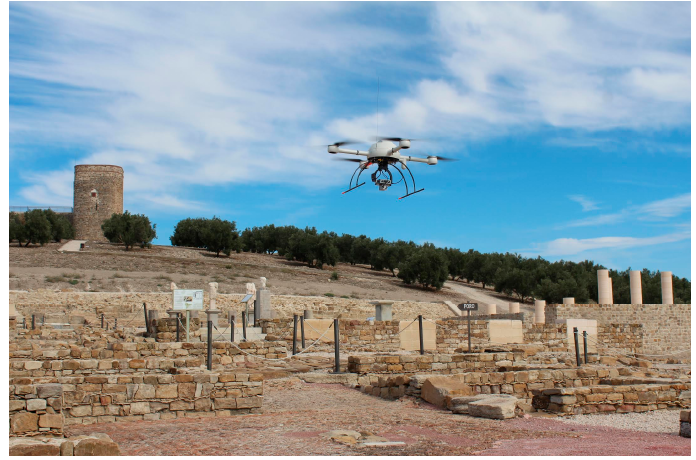
Figure 1. The MD4-1000 multi-rotor (Microdrones GmbH, Siegen, Germany) taking off over the study site. Table 1. Results of the field-calibrated Sony NEX-7 (Sony Corporation, Minato, Tokyo, Japan).